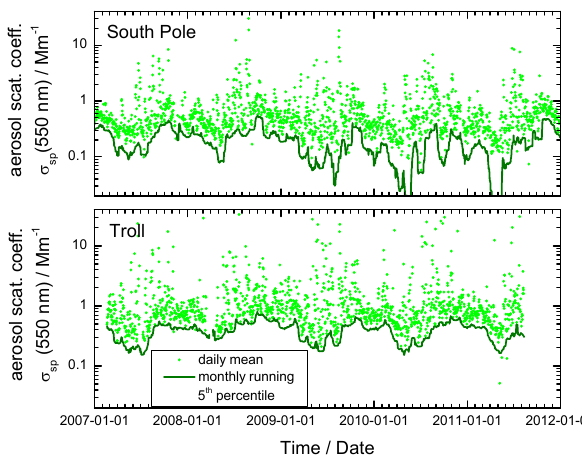
Fig. 3. Time series (2007–2011) of daily averaged total particle number concentration N tot measured by Condensation Particle Counter (CPC) at South Pole station (top panel, black dots), and corresponding time series of particle number concentration integrated over the PNSD N int measured by DMPS at Troll station (bottom panel, black dots). To highlight the annual cycle also in the particle number concentration, the plots contain the respective running 4-week 5th percentiles (grey line), which are again based on hourly values.